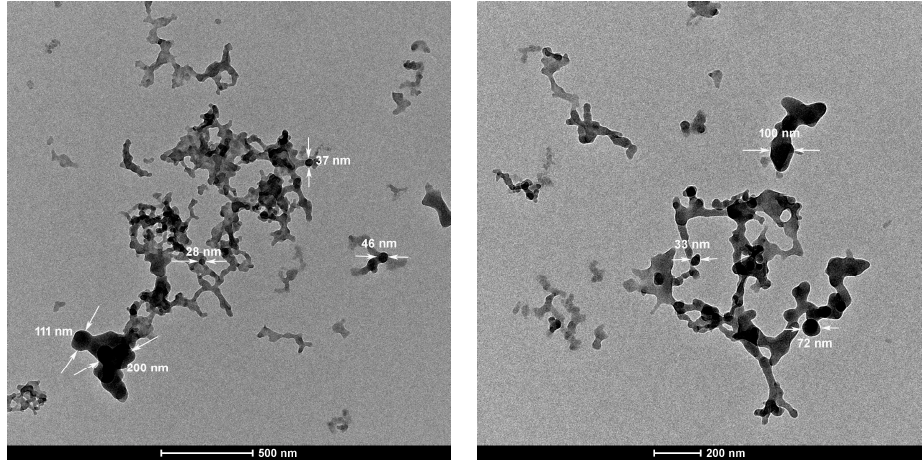
Figure 5. Transmission electron microscopy (TEM) images of the PTT prepared with a CuCl 2 /TT molar ratio of 1.0 and a TT concentration of 0.38 mol·L − 1 in DMF at 25 °C for 24 h.